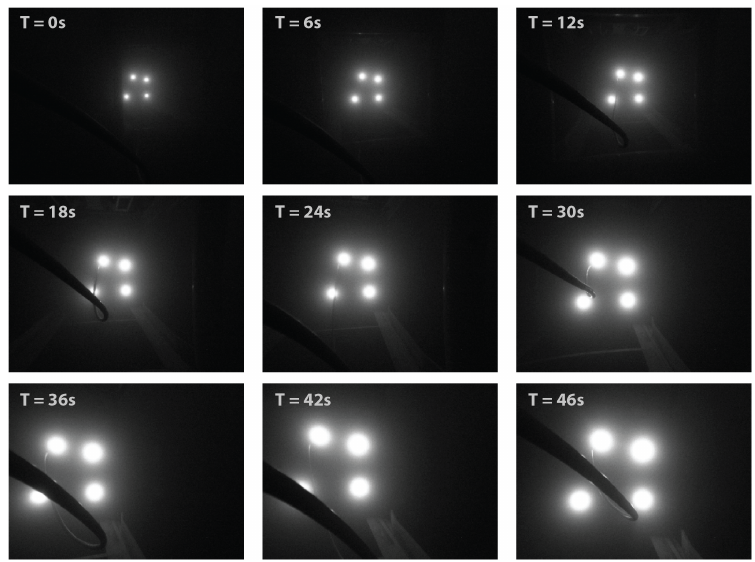
Figure 13. The dynamic test. The ROV position is estimated and corrected while ROV is approaching the light